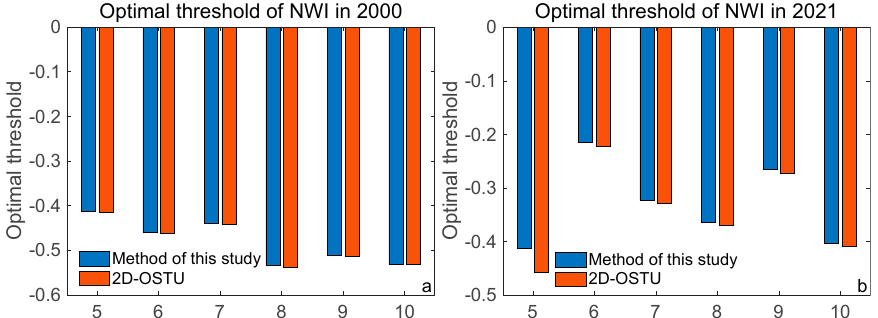
Figure 15. Optimal thresholds of NWI calculated by two adaptive algorithms of the study area of Chagan Lake in each month of 2000 ( a ) and 2021 ( b ).